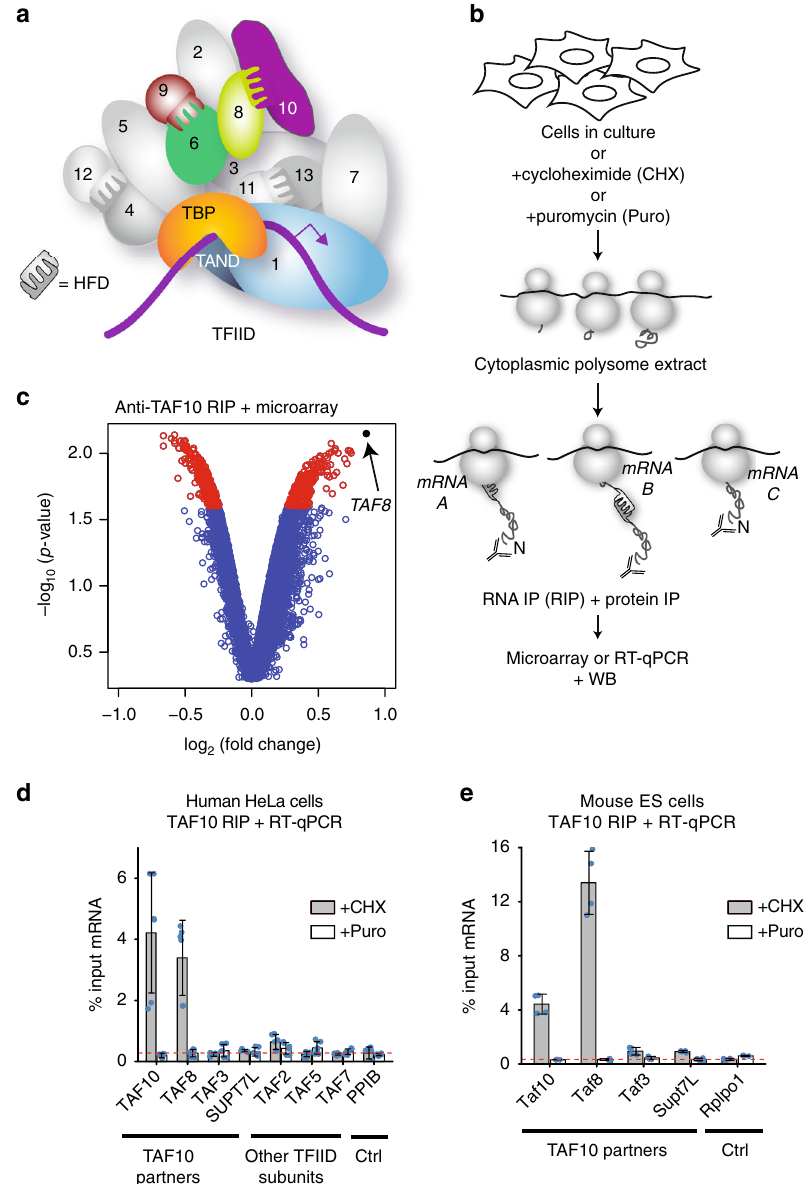
Fig. 1 Co-translational assembly of mammalian TFIID. a TFIID bound to promoter DNA. TFIID is composed of TBP and 13 TAFs (indicated by numbers). Subunits analysed in this study are highlighted in colour. The histone fold domain (HFD) interactions and the TBP-TAF1 TAND domain interaction are highlighted. b Schematic representation of polysome RIP assay. c Endogenous TAF10 was immunoprecipitated from HeLa polysome-containing extract using an antibody targeting the N-terminus of the protein. The enrichment of the precipitated RNAs was assessed globally by microarray. Volcano plot depicting microarray results as log2 of the fold change of IP over a mock IP. A p -value cut-off ≤ 0.025 was applied and corresponding transcripts are in red. TAF8 transcript is highlighted in black. d , e RIP-qPCR validation of the microarray results in HeLa ( d ) and mouse ES ( e ) cells. Error bars are ±SD from three (HeLa) or two (mESC) biological replicates and two technical replicates (represented by blue dots). Ctrl = negative control mRNA. PPIB and Rplp0 were used as unrelated control mRNAs. Source data provided as a Source Data